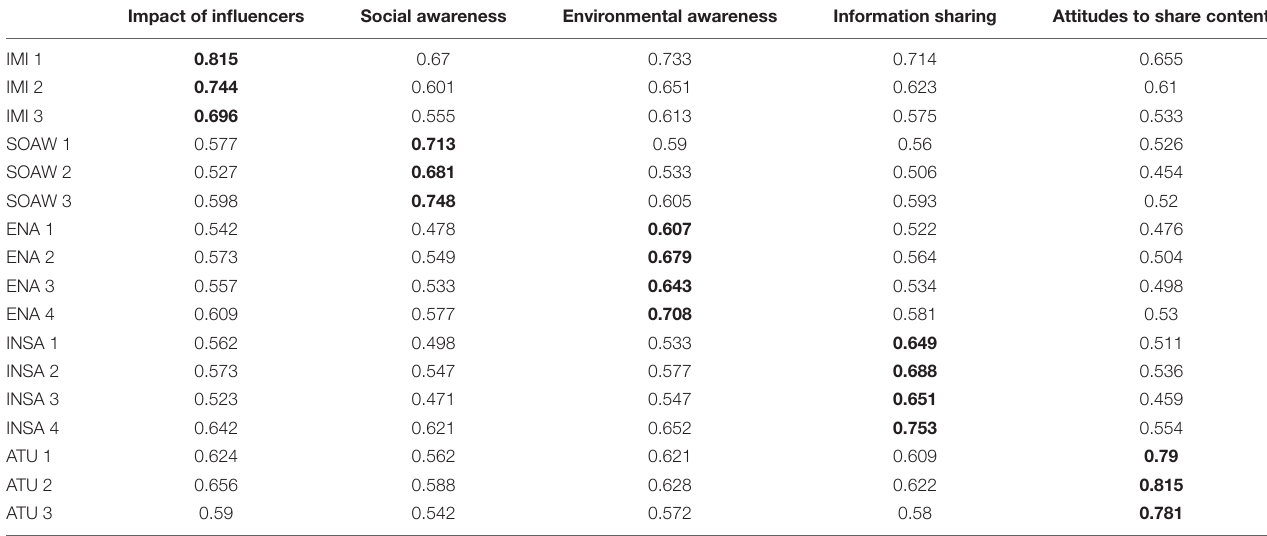
TABLE 6 | Cross loading